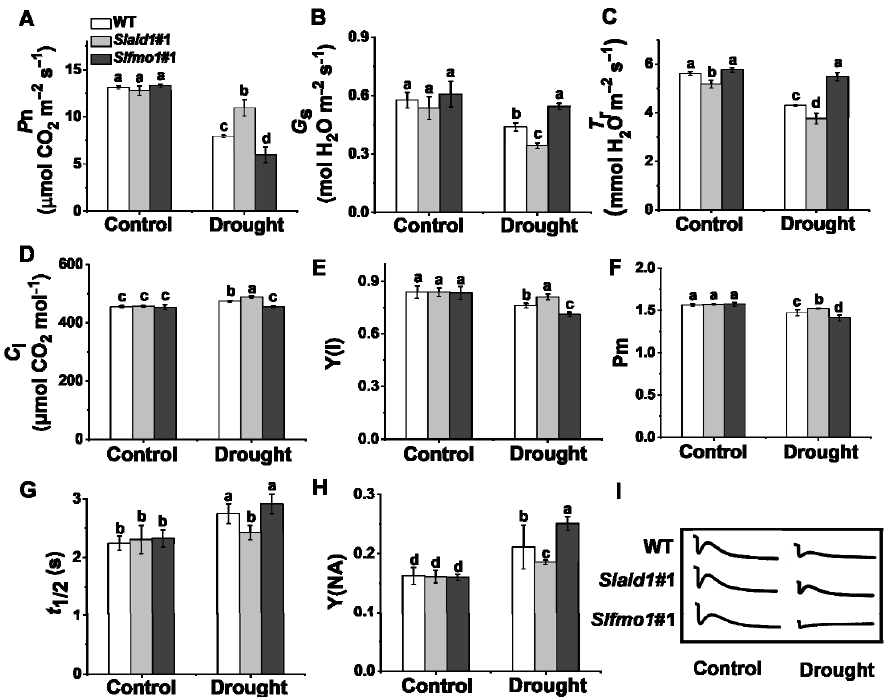
Figure 3. Changes in gas exchange parameters and PSI in Slald1 and Slfmo1 mutants under drought stress. The gas exchange parameters: net carbon dioxide (CO 2 ) assimilation rate ( A ), stomatal conductance ( B ), transpiration rate ( C ), and intercellular CO 2 concentration ( D ) of Slald1 , Slfmo1 mutants and WT plants after 48 h of control and drought treatment. PSI energy conversion: Y(I) ( E ), Pm ( F ), t 1/2 ( G ), Y(NA) ( H ), and the cyclic electron flow (CEF) around PSI of Slald1 , Slfmo1 mutants and WT plants after 48 h of control and drought treatment ( I ). The data are presented as mean values ± SD, n = 4. Different letters (a, b, c, d) above each bar indicate significant differences at p < 0.05 (Tukey’s test) among